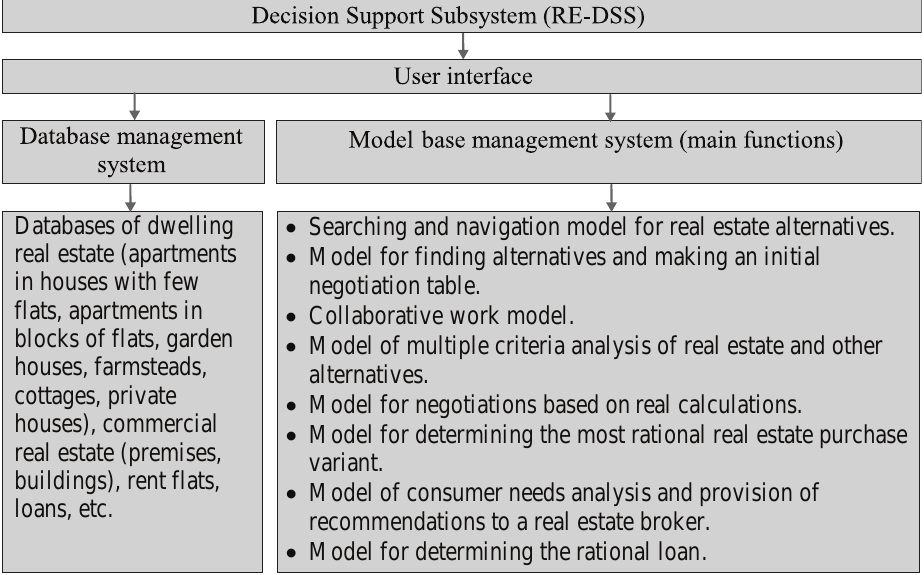
Figure 1. components of decision support